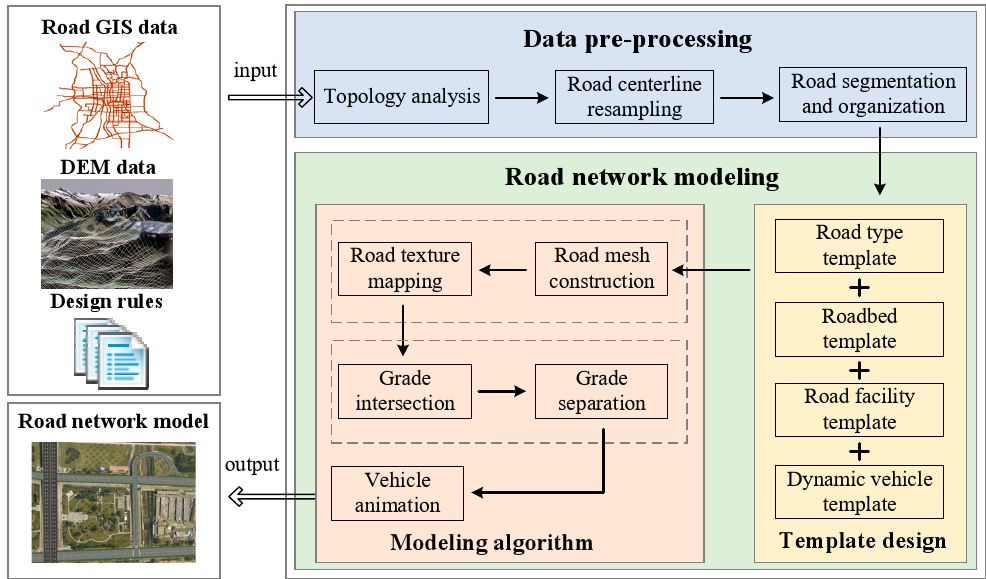
Figure 1. Framework of the road network modeling [18] .